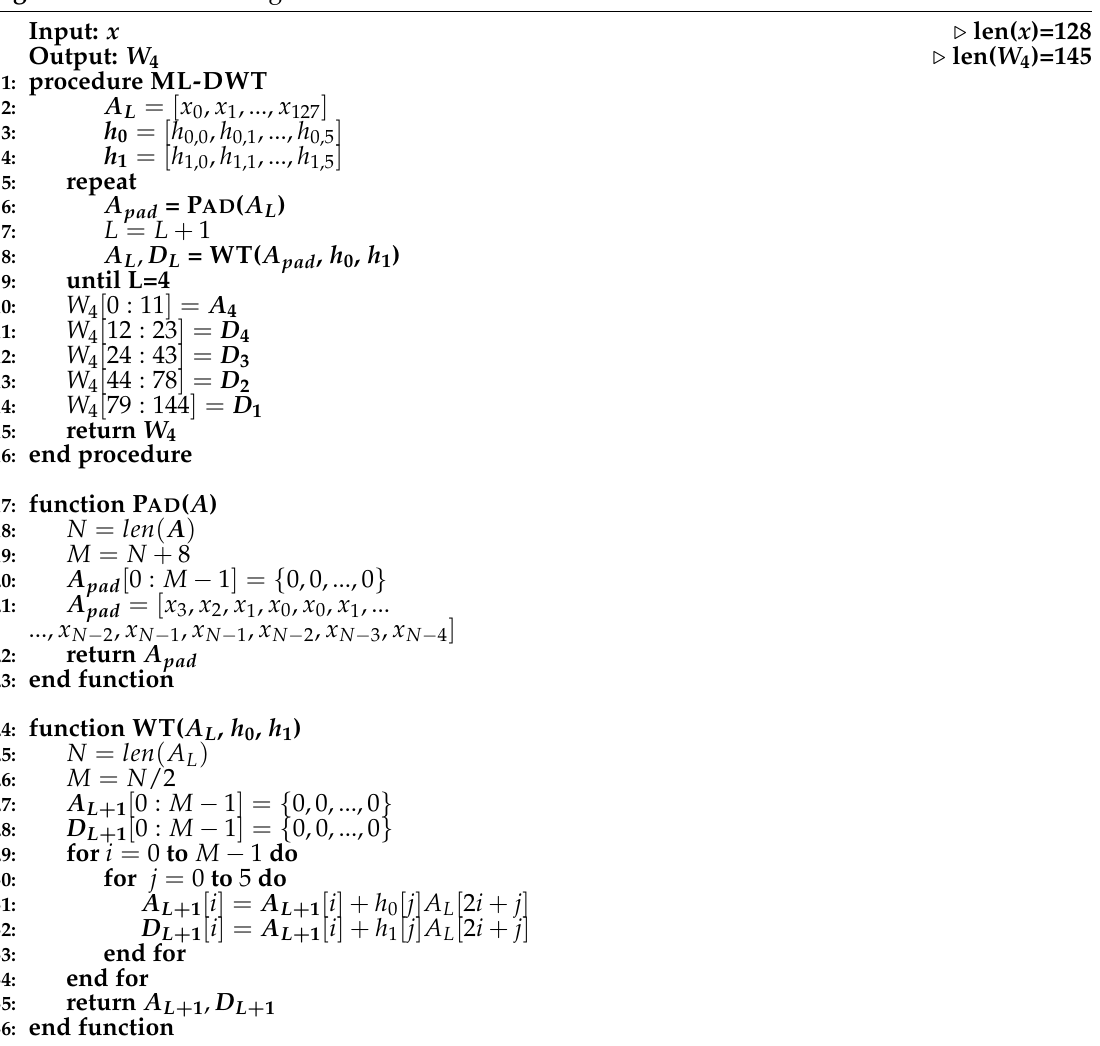
Algorithm 1 ML-DWT